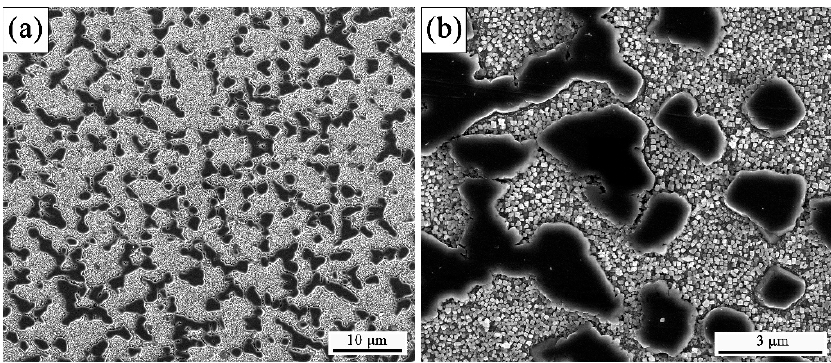
Figure 1. Thermodynamic phase diagram calculated by JMatPro software.